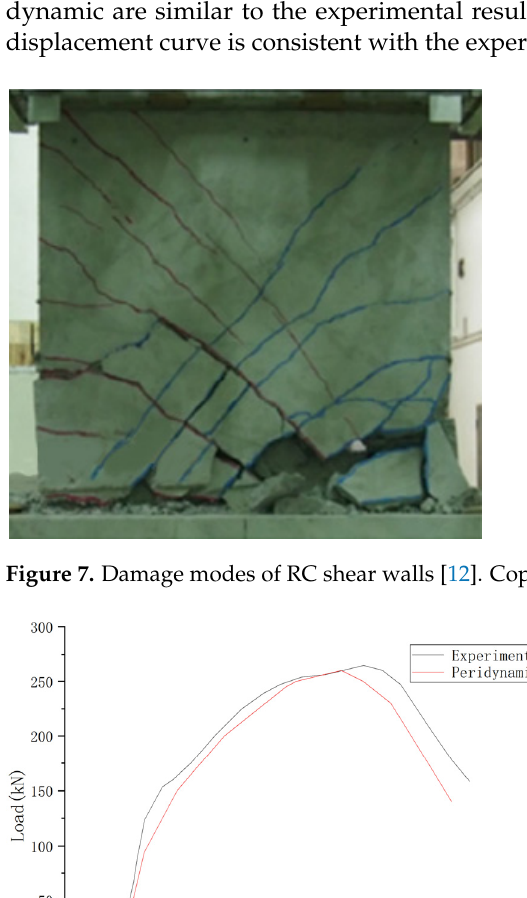
Figure 8. Load-displacement curve [12].